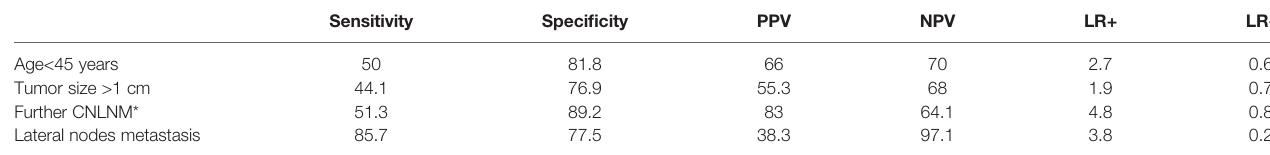
TABLE 4 | Ability of age<45 years, tumor size>1 cm, potential CNLNM and lateral nodes metastasis to predict RLNIZ lymph nodes